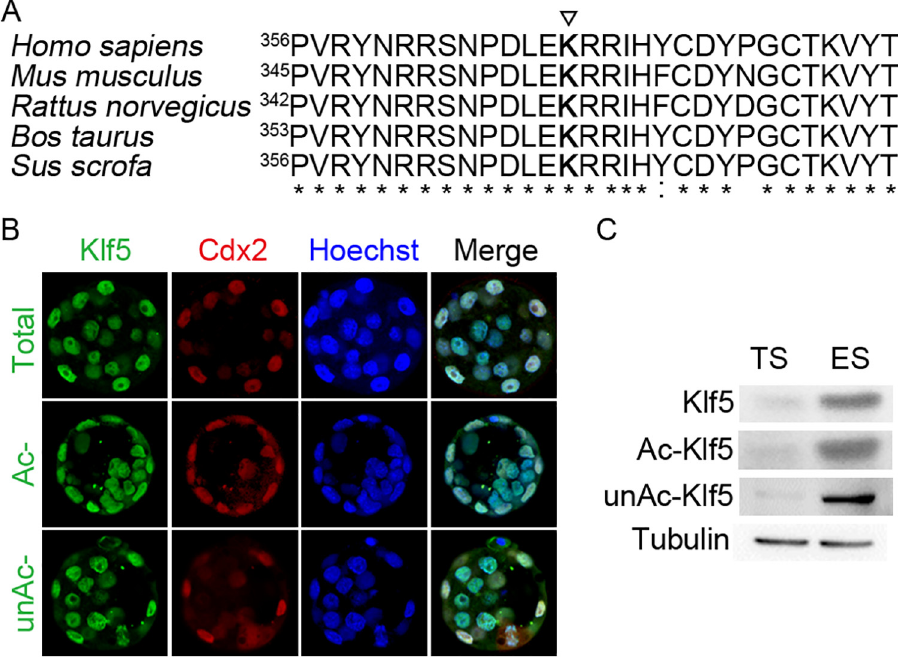
Fig 1. Klf5 expression in the blastocyst, ESCs and TSCs. (A) Comparison of different species Klf5 protein sequences around the human KLF5 acetylation site. The numbers mark the coordination of the first shown residues “ P ” in Klf5 proteins of different species. The triangle highlights the conserved lysine residue 369 that is acetylated in human KLF5. (B) Immunofluorescence staining of total, acetylated (Ac-), and unacetylated (unAc-) Klf5 in the blastocyst. Cdx2 expression was shown to mark TE cells, and nuclei were stained by Hoechst. (C) Western blot of total, Ac-, and unAc-Klf5 in mouse ESCs and TSCs. Tubulin was used as a loading